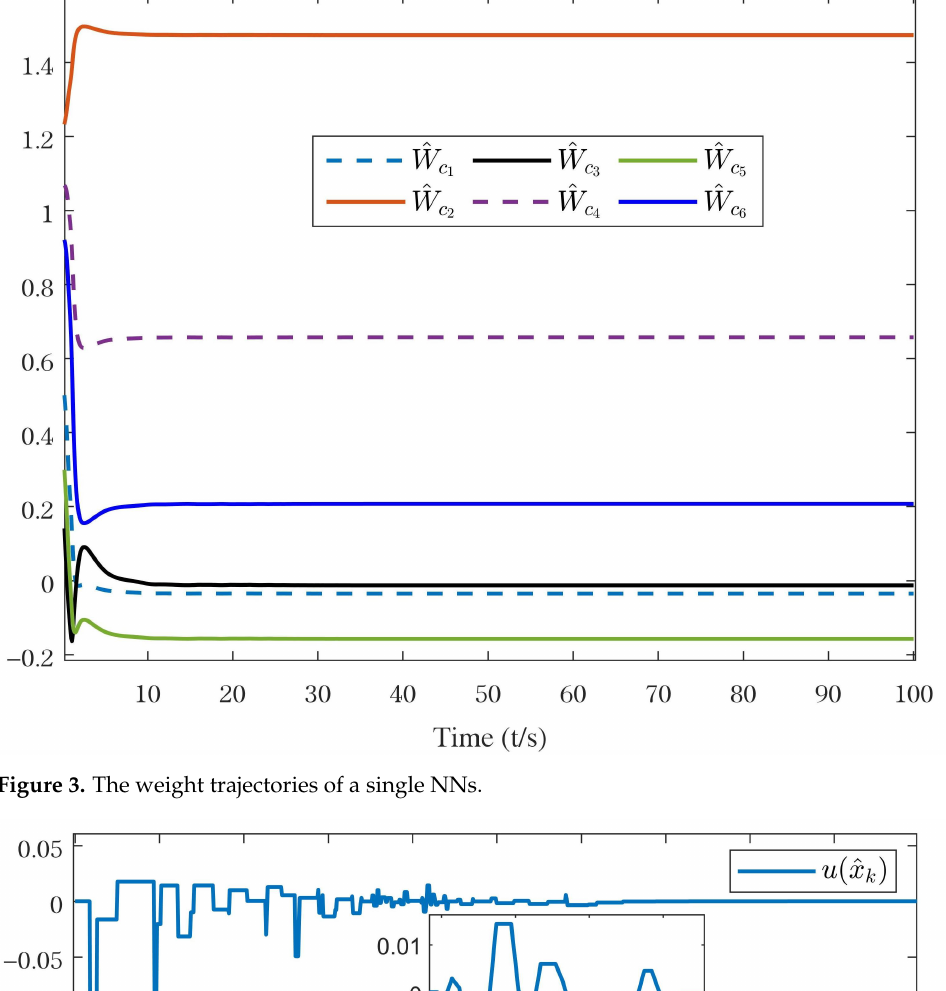
Figure 3. The weight trajectories of a single NNs.